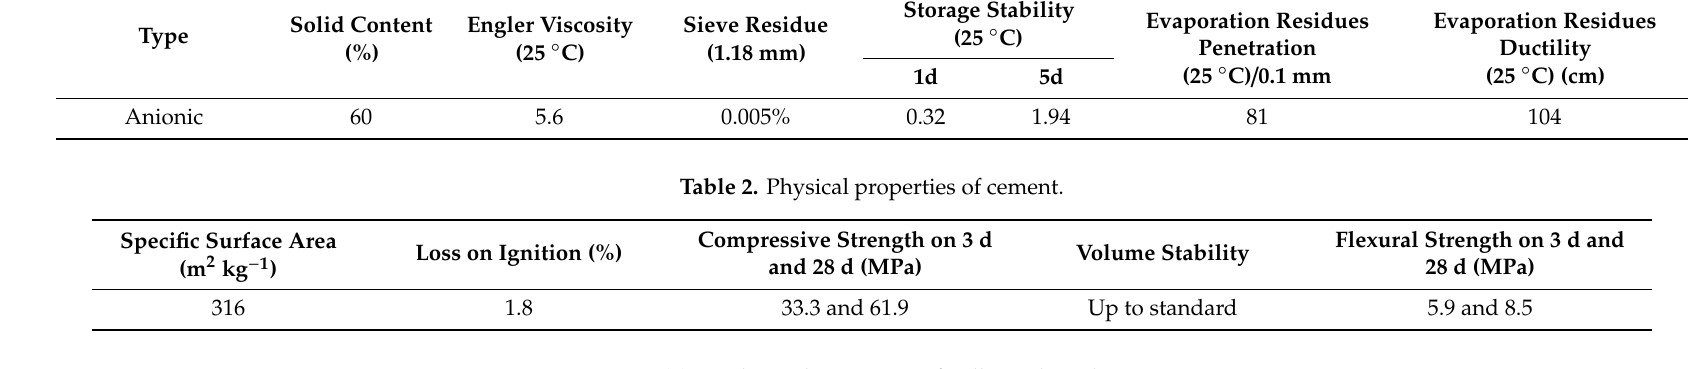
Table 3. Physical properties of pelletized sand.